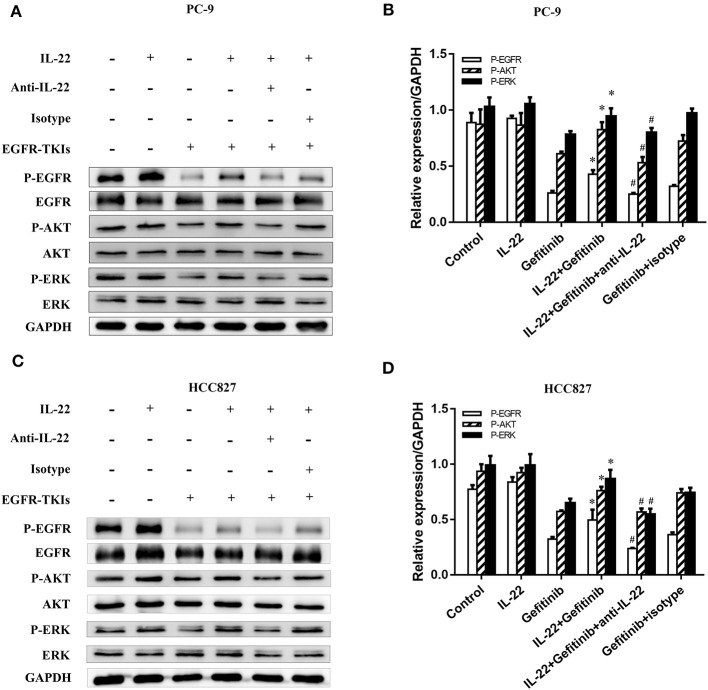
IL-22 promoted activation of the phosphorylated EGFR/AKT/ERK in NSCLC cells. (A) PC-9 and (C) HCC827 cells were incubated in the presence or absence of gefitinib (IC50) for 3 h prior to exposure to 50 ng/ml IL-22 (+/−), 104 ng/mL IL-22 neutralizing antibody (+/−) and mouse IgG1 Isotype control (+/−) for additional 24 h, and the protein samples were analyzed by western blot with indicated antibodies. (B) PC-9 and (D) HCC827 cells densitometric analysis of western blots for the phosphorylated protein. *P < 0.05 compared with gefitinib group. #P < 0.05 compared with IL-22 plus gefitinib group. Data were presented as mean ± SEM of three independent experiments. anti-IL-22, IL-22 neutralizing antibody; Isotype, mouse IgG1 Isotype control.